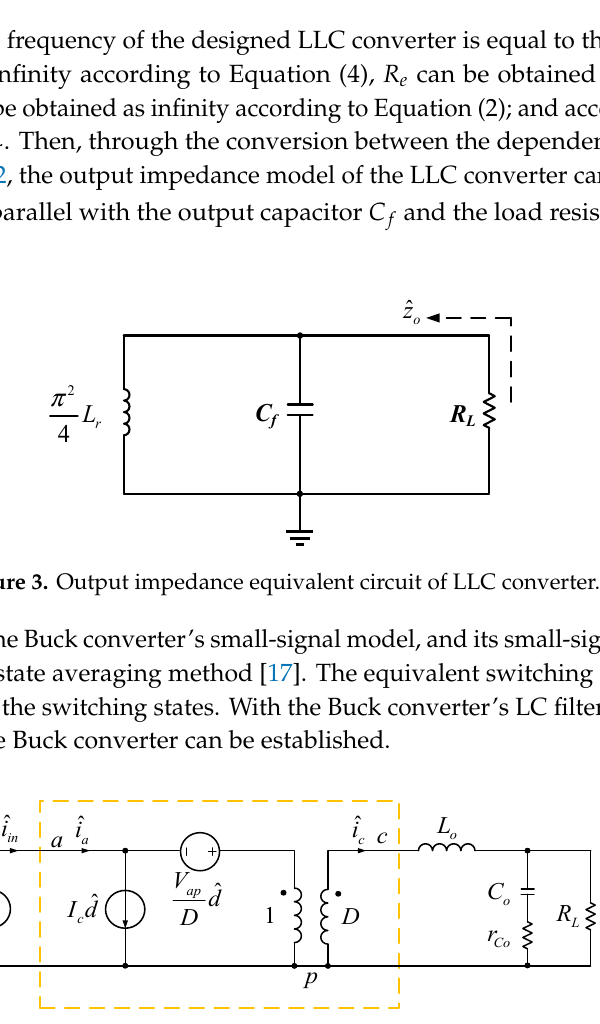
Figure 4. Small-signal model of Buck converter.